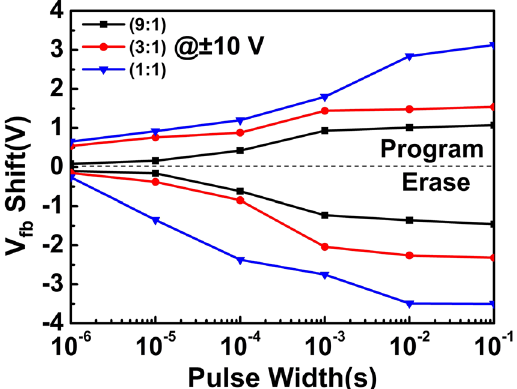
Figure 4. The programing/erasing (P/E) characteristics of TTO(9:1), TTO(3:1) and TTO(1:1) CTM devices.